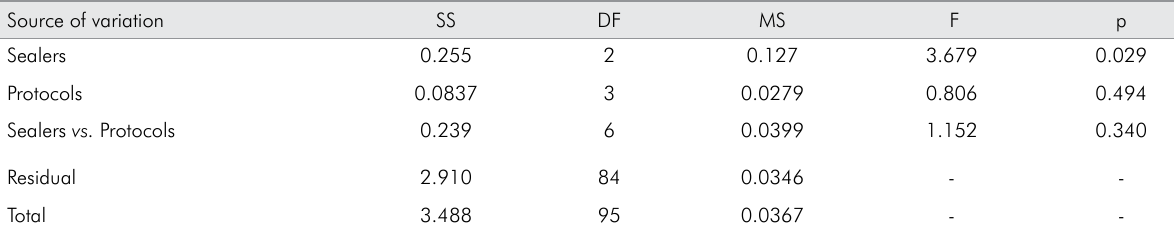
Table 1. Analysis of variance